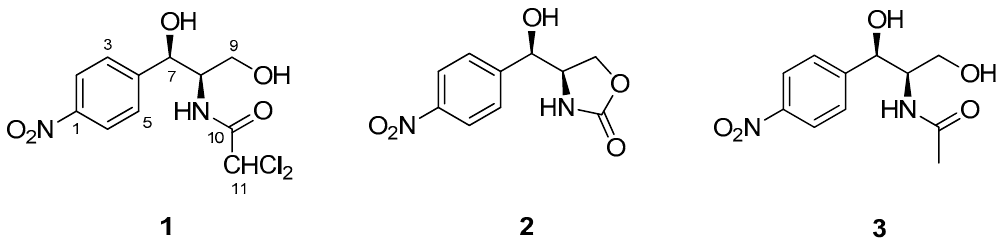
Figure 1. Structures of the natural compounds 1 – 3, isolated from Acremonium vitellinum .